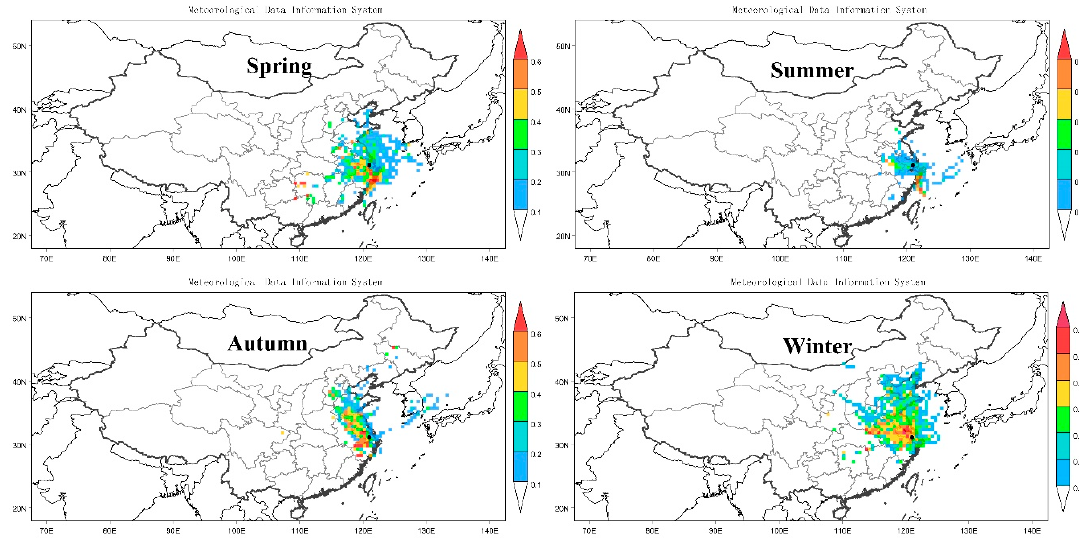
Figure 6. Source regions of PM 2.5 from the potential source contribution function (PSCF) model in four seasons.